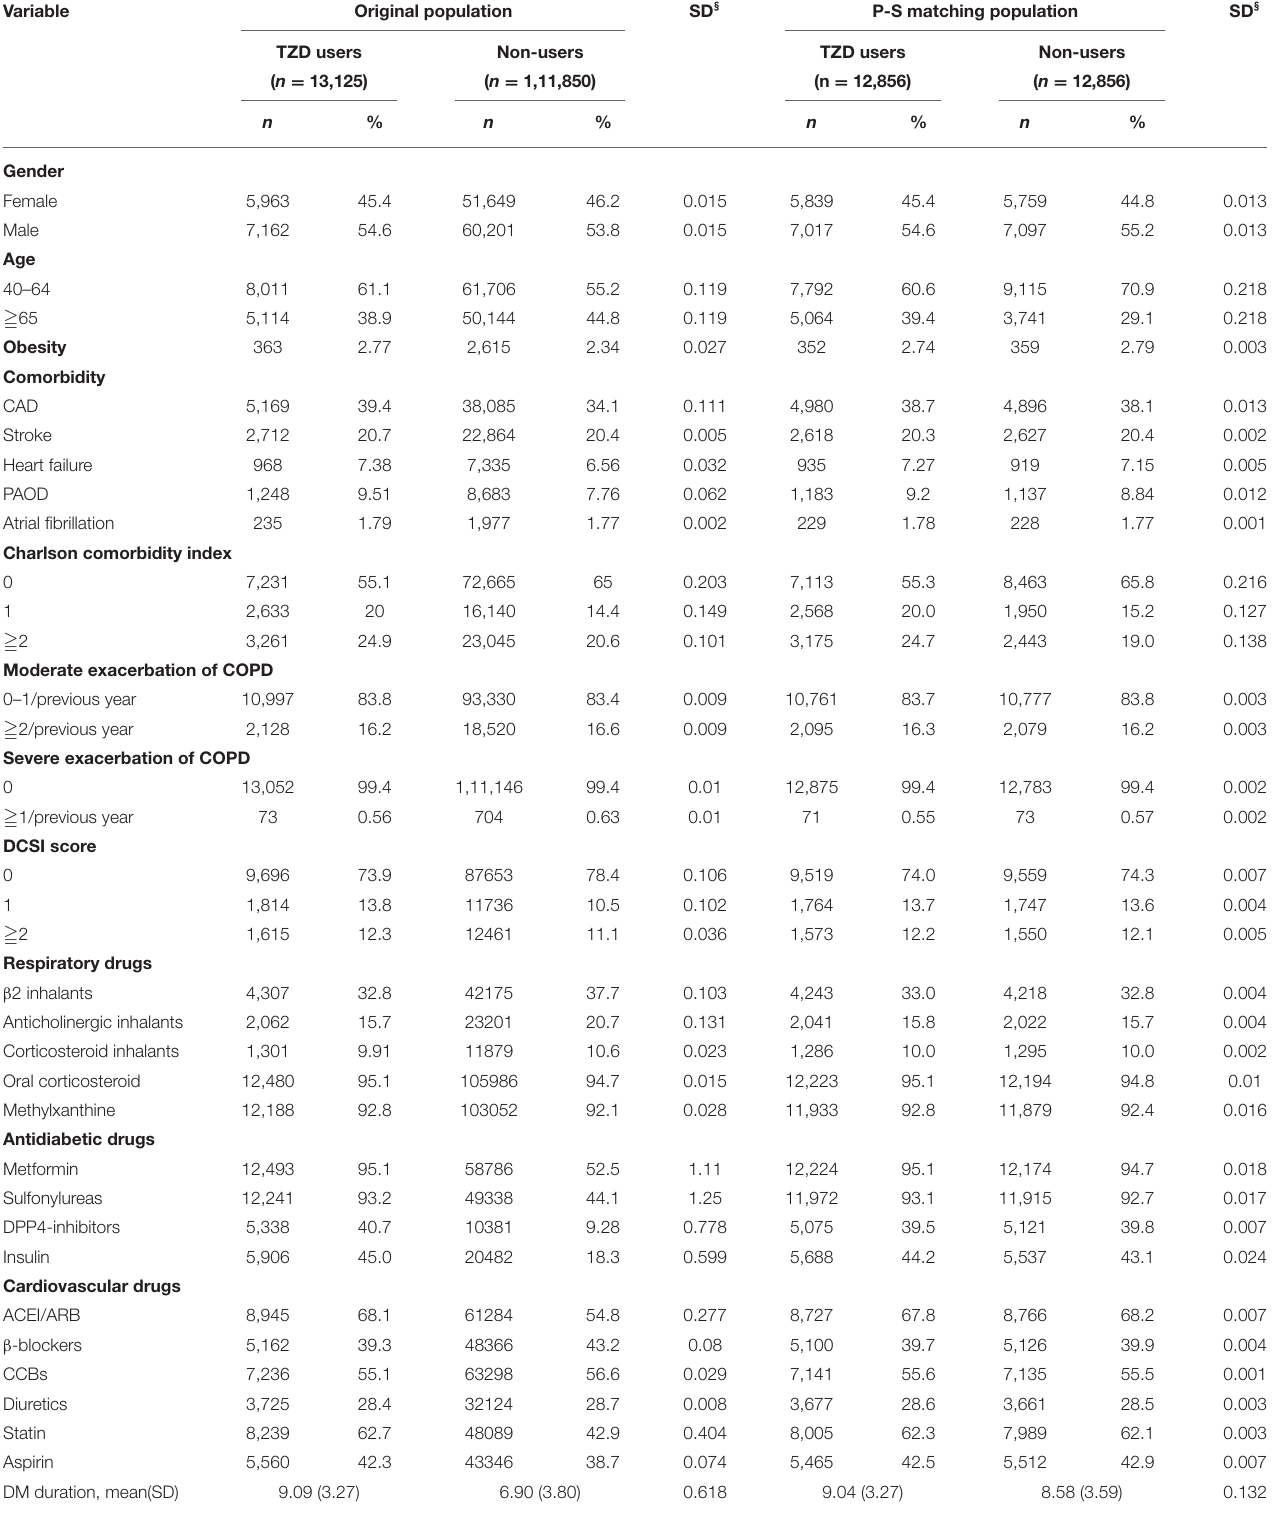
TABLE 1 | Patients’ baseline clinical and demographic characteristics.